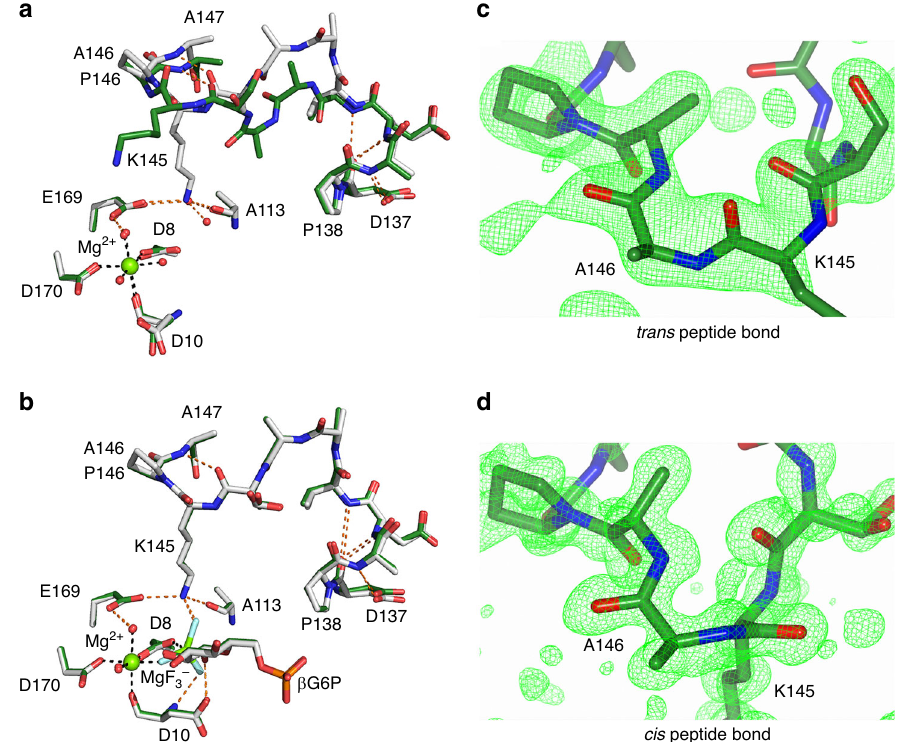
Fig. 4 Conformational plasticity of the active site of β PGM. a , b Active sites of β PGM WT (as conformer A) and β PGM P146A superposed on the core domain. a Selected residues are shown as sticks for the crystal structures of β PGM WT (grey carbon atoms; PDB 6YDL) and β PGM P146A (dark green carbon atoms; PDB 6YDK). In β PGM WT , a cis K145 – P146 peptide bond allows coordination of the K145 sidechain by E169 and A113, whereas in β PGM P146A a